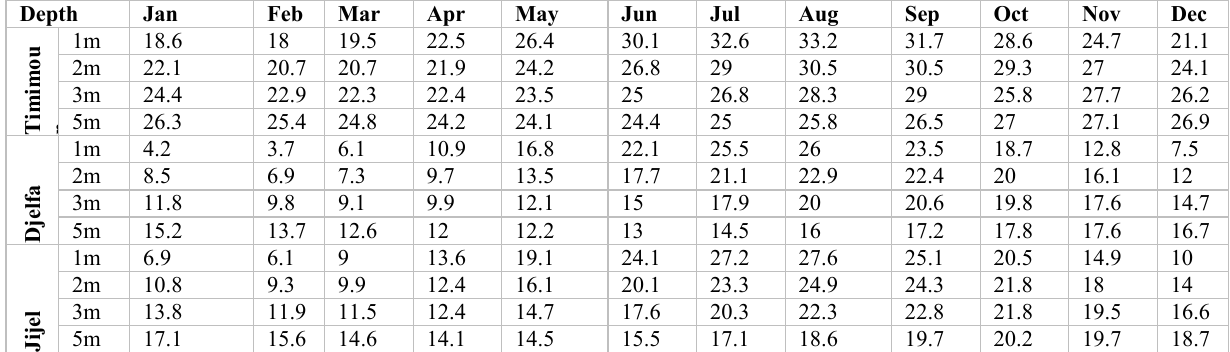
Table 6. Validation of air temperature in the buried pipe against Hatraf et al. [28]. Table 7. The average of soil temperature at different depths during a